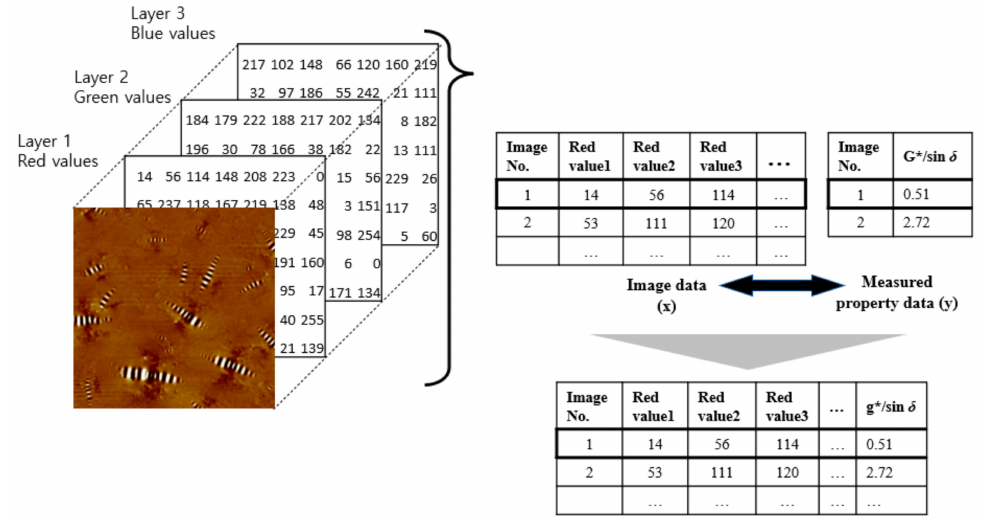
Figure 5. Conceptual diagram of data matching.